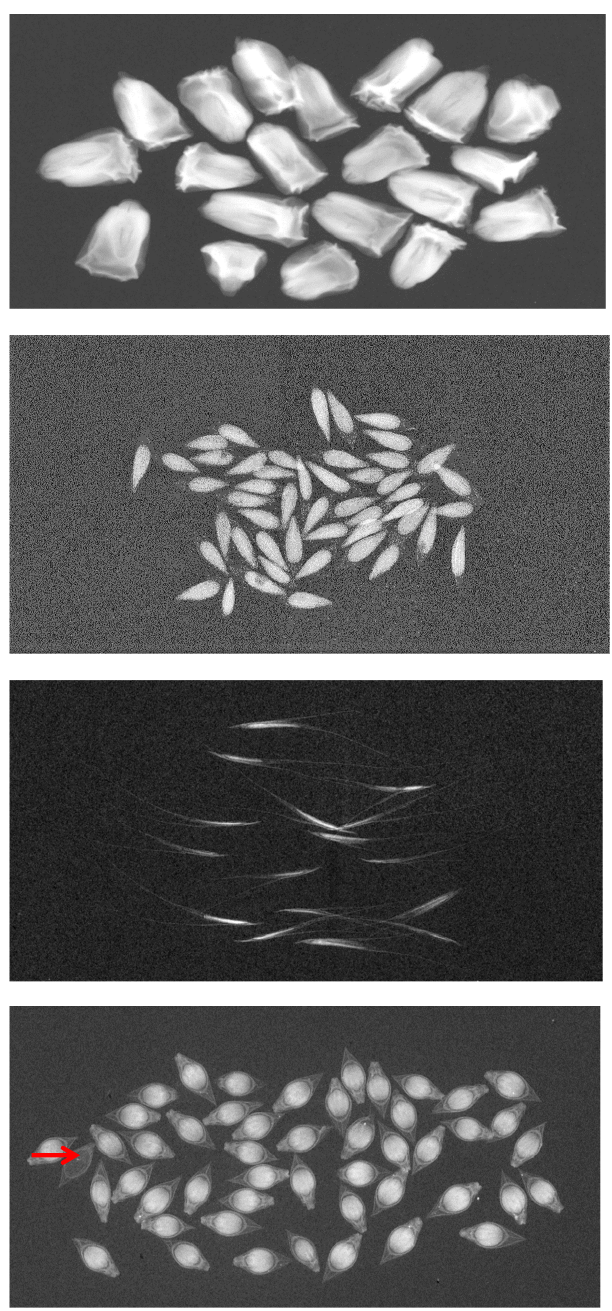
Figure A1. X-ray images of maize (Zea mays L.), lettuce ( Lactuca sativa L), curly windmill grass ( Enteropogon acicularis L.), and liverseed grass ( Urochloa panicoides P.Beauv) seed lots used in the bioassay experiments. The images show >95% seed fill for the four seed lots. The red arrow points to a nonviable seed.